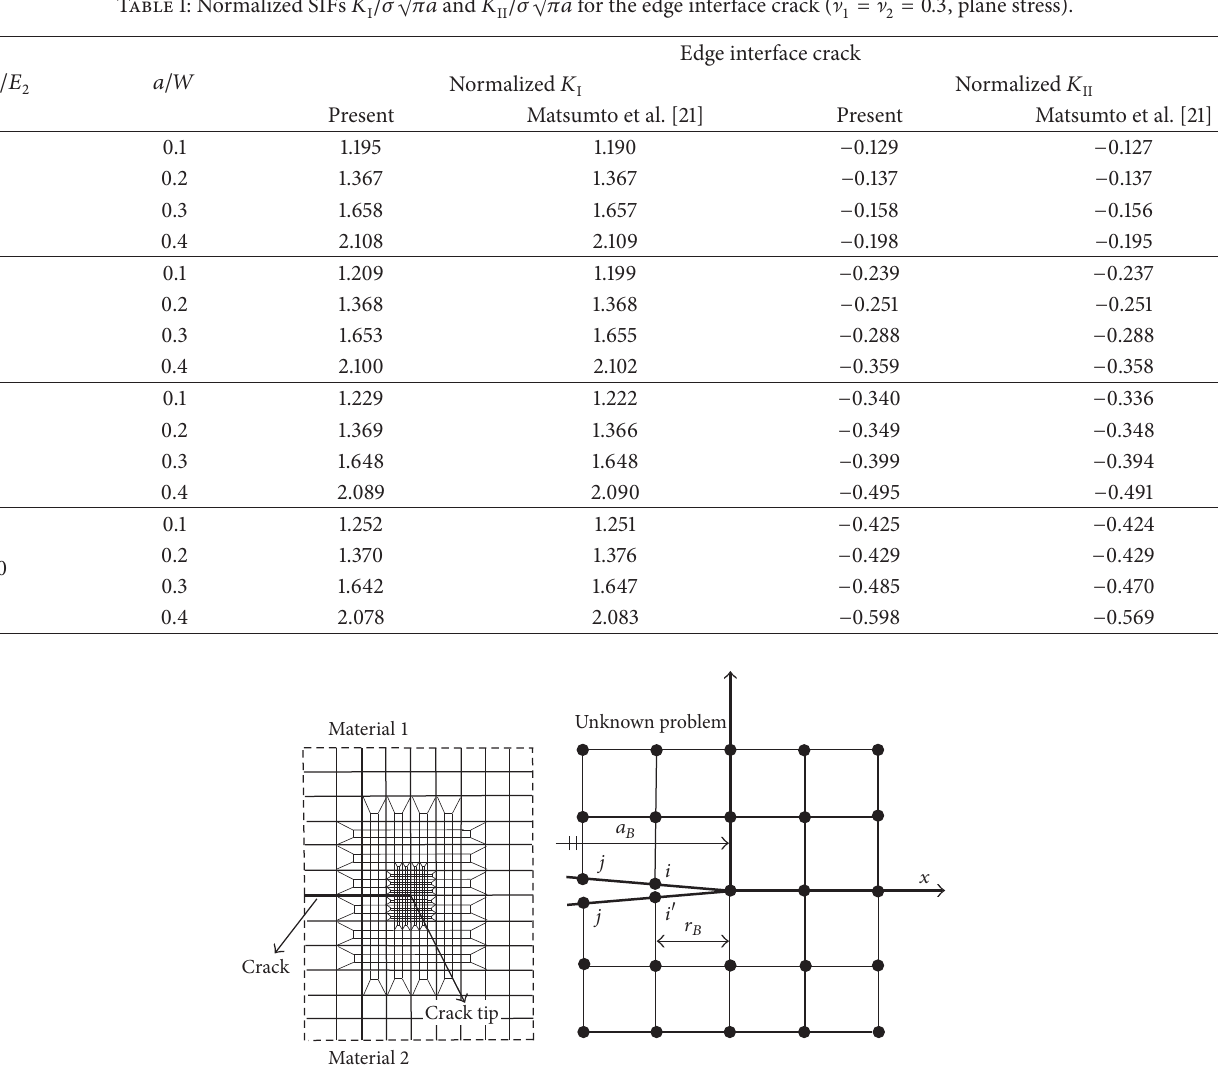
Table 1: Normalized SIFs 𝐾 I /𝜎√𝜋𝑎 and 𝐾 II /𝜎√𝜋𝑎 for the edge interface crack ( ] 1 = ] 2 = 0.3 , plane stress).